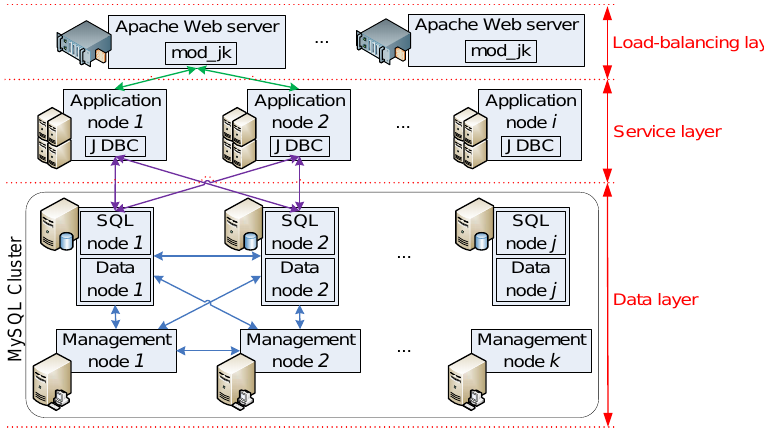
Figure 9. High-available and scalable IIP prototype deployment.